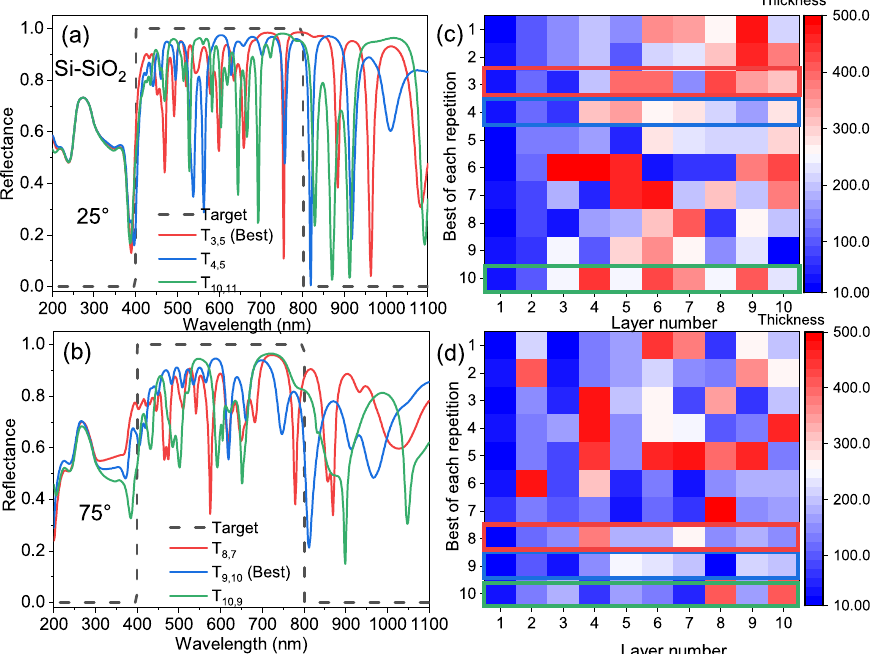
Figure 7. Reflectance spectra for Si-SiO 2 system at ( a ) 25 ◦ and ( b ) 75 ◦ of incidence compared to the target reflectance (dashed lines) for non-polarized light (color lines). ( c , d ) Chromosomal representation of the solutions. In this representation, it can be noticed that the configuration of layers is not